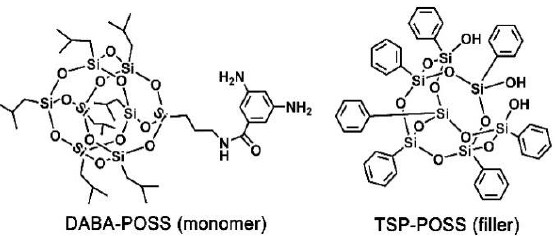
Figure 1. Nanocaged polyhedral oligomeric silsesquioxane (POSS) units used in the current work.